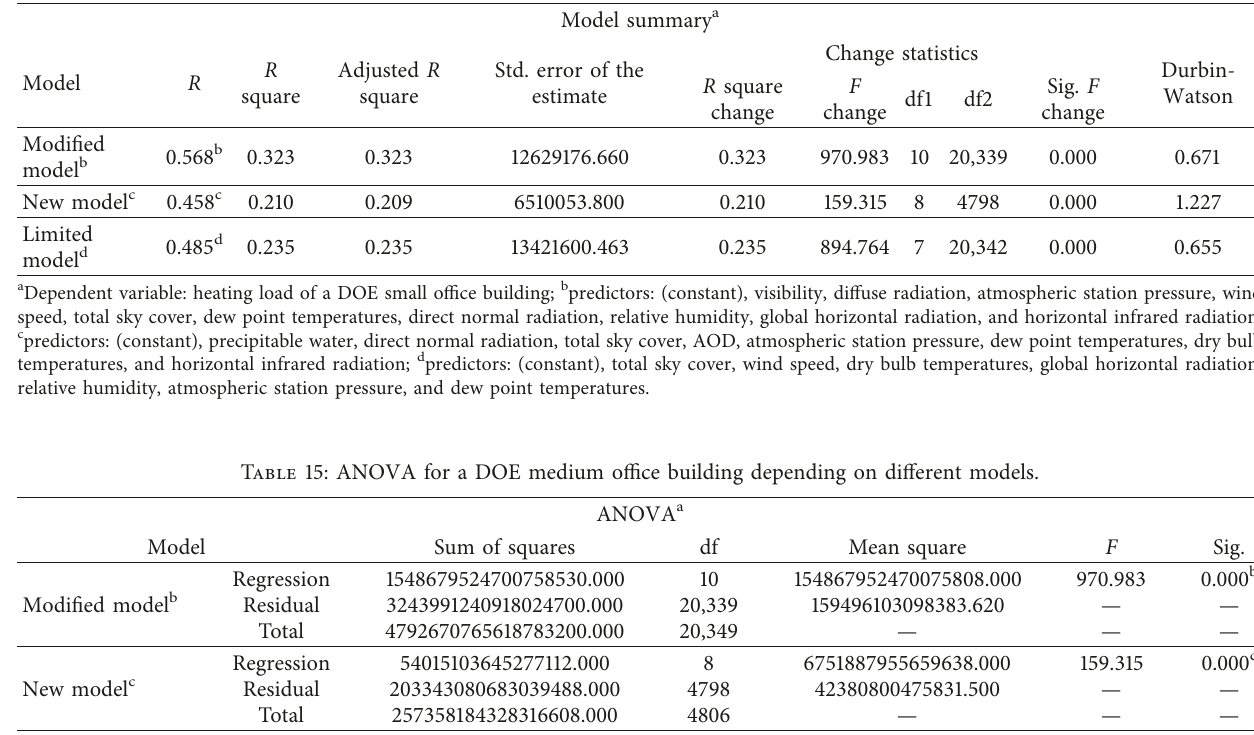
Table 16: Residual statistics for a DOE medium office building depending on different models.